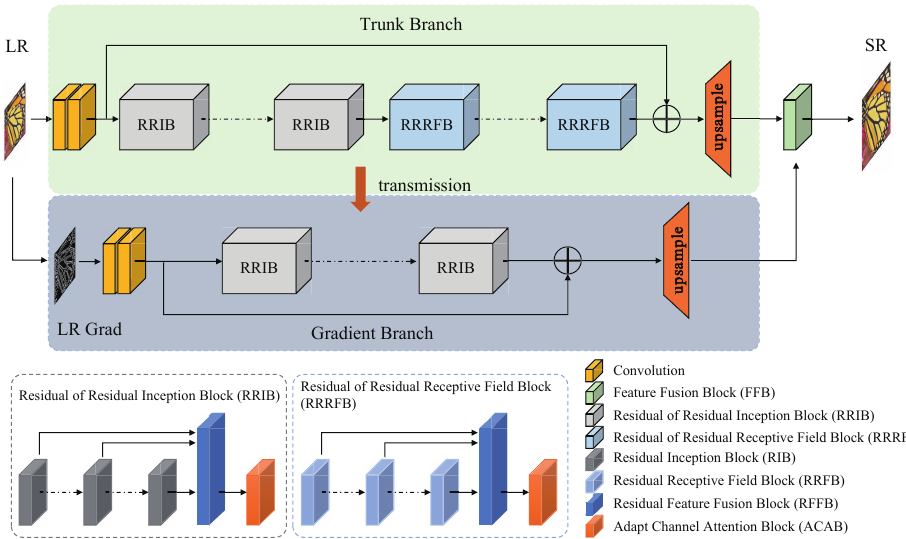
Figure 1. Network structure of the proposed GFSR. The network is divided into two branches, the trunk branch for extracting the intermediate features from the LR image, as shown in the upper part of this figure, and the gradient branch for extracting the gradient map of the LR image, as shown in the lower part of this figure. Notably, the intermediate features extracted on the trunk branch are propagated to the gradient branch to reduce the number of parameters; at the same time, the gradient features extracted on the gradient branch are propagated to the trunk branch through a feature fusion block to guide the super-resolution